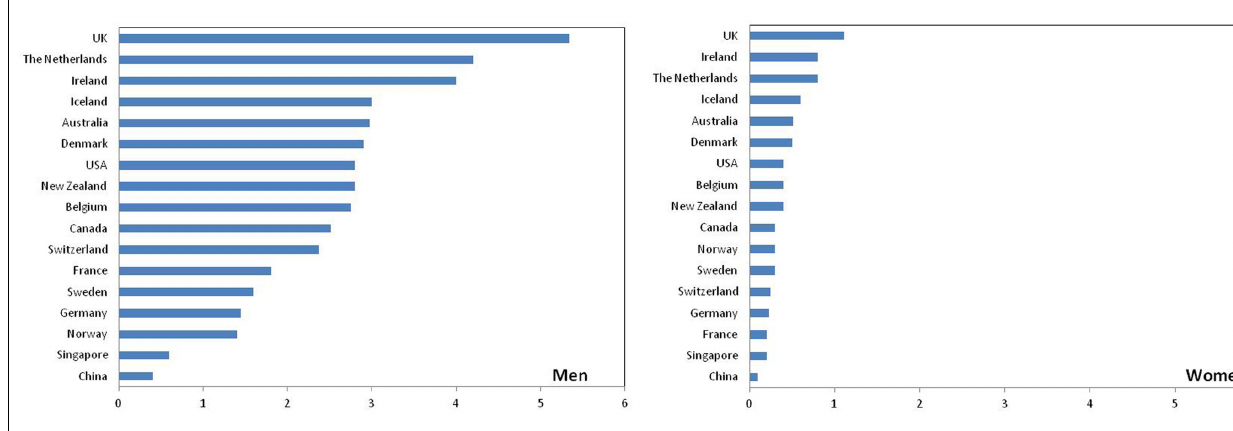
FIGURE 1 |Age-adjusted annual incidence of esophageal adenocarcinoma (per 100,000; Data source: Curado et al., 2007).